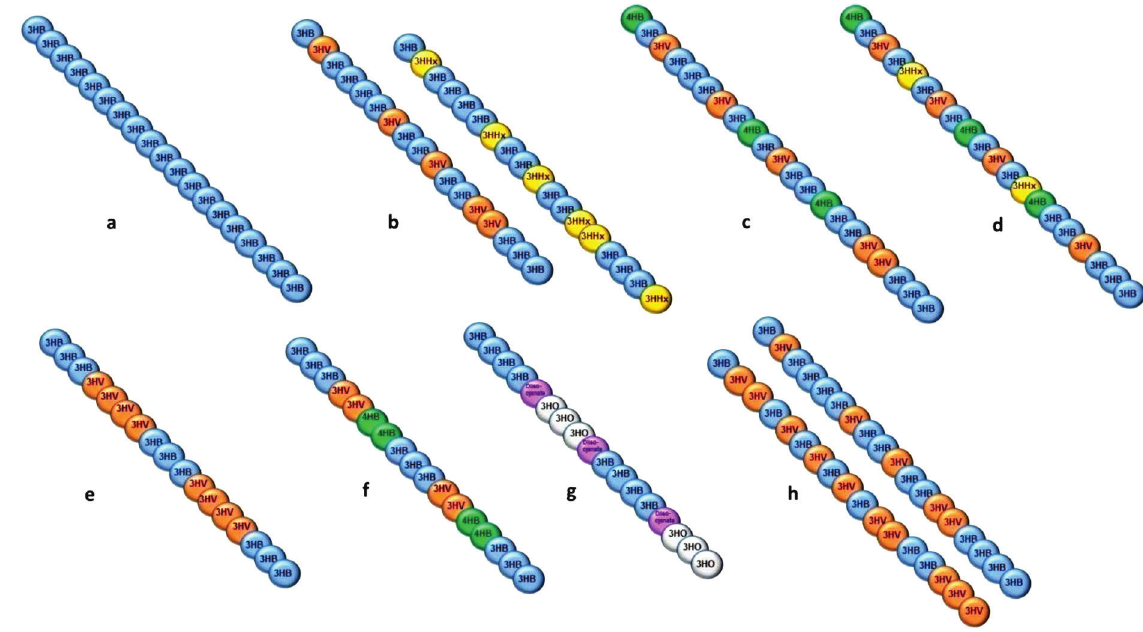
Fig. 5 – Schematic of PHAs of different microstructure. Blue spheres: 3HB; orange spheres: 3HV; green spheres: 4HB; yellow spheres: 3HHx; grey spheres: 3HO; pink spheres: linker diisocyanate. a: PHB homopolyester; b: copolyesters with random distribu- tion (left: poly(3HB-co-3HV), right “Nodax-type” poly(3HB-co-3HHx)); c: poly(3HB-co-3HV-co-4HB) terpolyester with random distribution; d: poly(3HB-co-3HV-co-4HB-co-3HHx) quarterpolyester with random distribution; e: diblock b-PHA poly(PHB-b-PHV); f: triblock b-PHA poly(PHB-b-PHV-b-P4HB); g: polyesterurethane (PEU) with “hard” PHB and “soft” PHO blocks linked by diiso- cyanate; h: PHA blend of 3HV-rich and 3HV-poor poly(3HB-co-3HV) randomly distributed